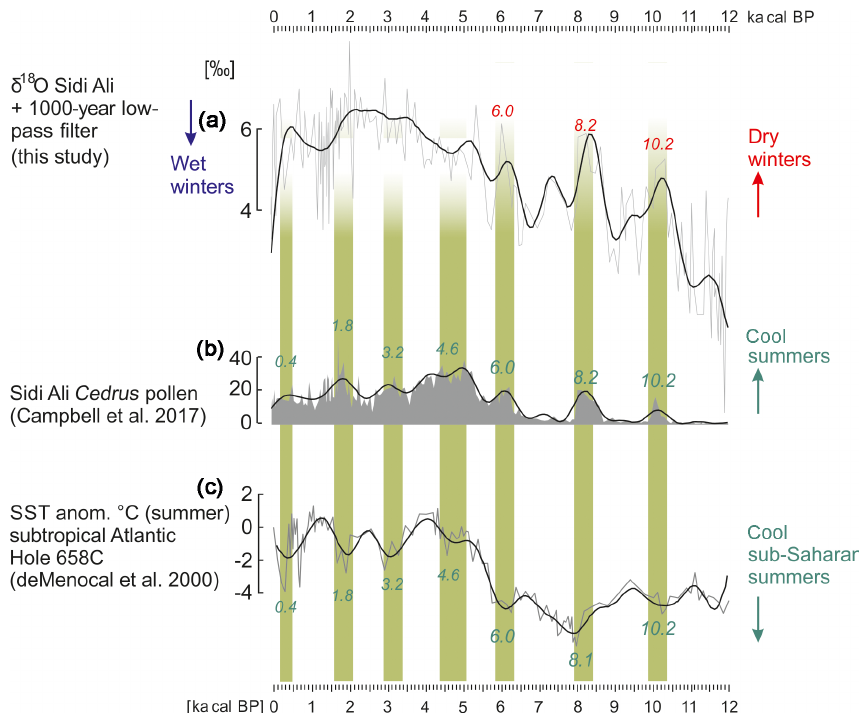
Figure 2. Western Mediterranean (Sidi Ali) winter rain and Cedrus records versus a subtropical summer temperature record. (a) Improved Holocene Sidi Ali δ 18 O record from closely related species Fabaeformiscandona sp. and Candona sp. (Zielhofer et al., 2017a and this study). The grey line represents the original data. The black line shows results of a low-pass filter (1000 years) removing centennial to multi-centennial variability. Red numbers indicate major dry winter phases in the Western Mediterranean. (b) Sidi Ali Cedrus pollen record (Campbell et al., 2017). The black line shows results of a low-pass filter (1000 years). (c) Summer sea surface temperature (SST) at Hole 658C (deMenocal et al., 2000). The grey line represents the original data. The black line shows results of a low-pass filter (1000 years). Olive numbers and pale olive bars indicate synchronous phases of summer cooling in the Middle Atlas (Sidi Ali) and reduced summer SST in the subtropical North